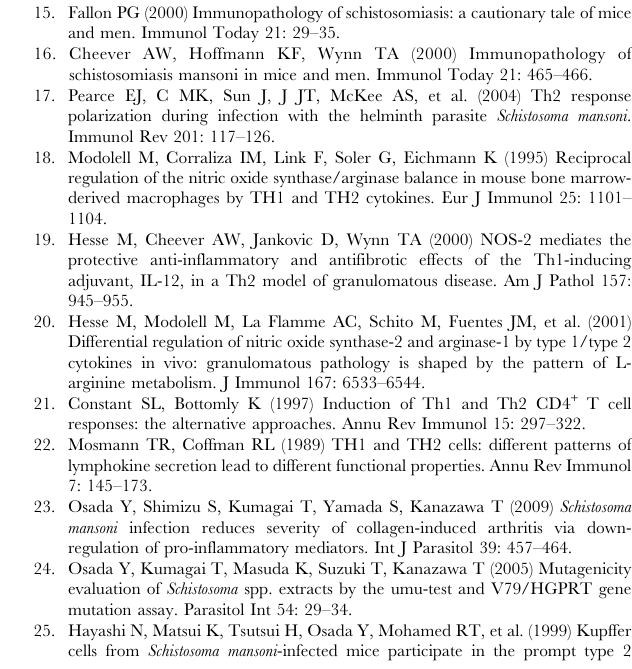
lymphocytes were investigated. This experiment is representative of three independent experiments. (TIF) Figure S6 TCR ligation is required for the induction of cytokine production by the hepatic lymphocytes. In the absence of TCR stimulation, ICS was conducted using fresh hepatic lymphocytes isolated from S. mansoni -infected mice at 6 weeks PI. This experiment is representative of two independent experiments. (TIF) Figure S7 The hepatic c 4 and c 13 cells showed effector memory T cell-like surface phenotypes. Hepatic lympho- cytes were isolated from S. mansoni -infected mice at 6 weeks PI, and ICS was conducted after TCR stimulation. The percentages in the insets represent the proportions in c 4 or c 13 cells. Similar results were obtained in two independent experiments. (TIF) Figure S8 Both c 4 and c 13 cells little expressed the surface markers of Tfh cells. Hepatic lymphocytes were isolated from S. mansoni -infected mice at 6 weeks PI and ICS was conducted upon TCR ligation. The percentages in the insets represent the proportions in c 4 or c 13 cells. One representative result of two independent experiments is shown.